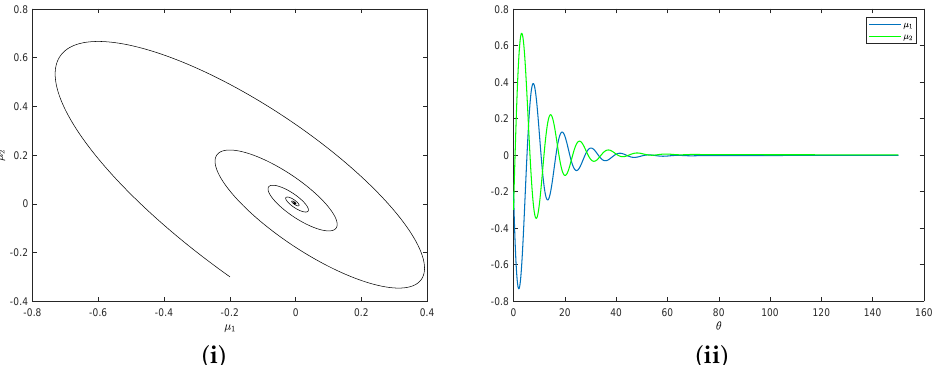
Figure 4. ( i ) Phase diagram of the circuit system for µ 0 = ( − 0.2, − 0.3 ) , a 1 = 0.5, a 2 = 0.3, b = 0.8, c = 2, and f = 0; ( ii ) evolution of the state µ 1 , µ 2